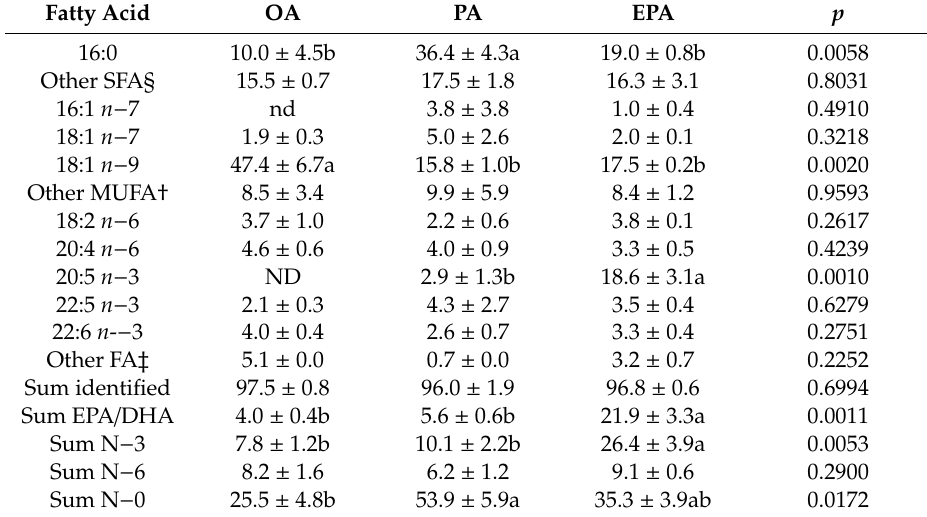
Table 1. Fatty acid composition (% of total) in mature Atlantic salmon adipocytes. Differentiated cells at day 9 were incubated with oleic (OA), palmitic (PA), or eicosapentaenoic acid (EPA) for 72 h (mean ± SEM; n = 3).